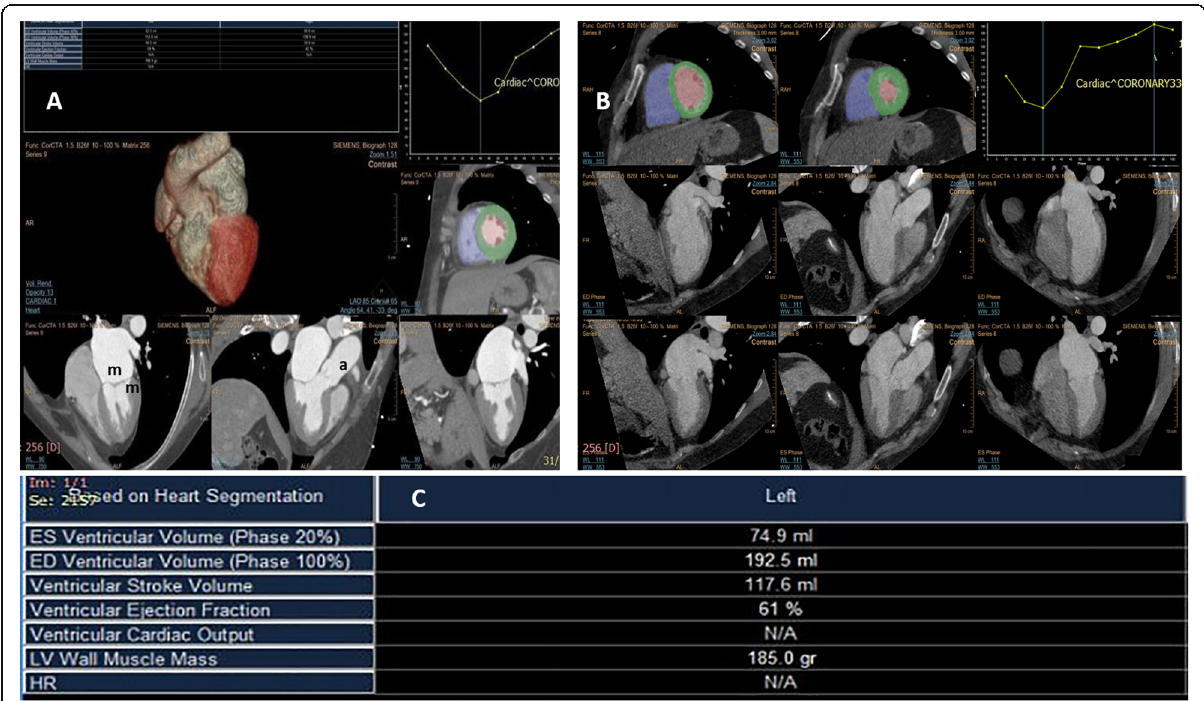
Fig. 1 a Short axis segmentation and longitudinal planes of the heart by cardiac CT. b The upper row shows short-axis view during diastole and systole. Middle row shows two-chamber view, three-chamber view, and four-chamber view during diastole. Lower row shows a two-chamber view, three-chamber view, and four-chamber view during systole C-MDCT display table containing LV functional